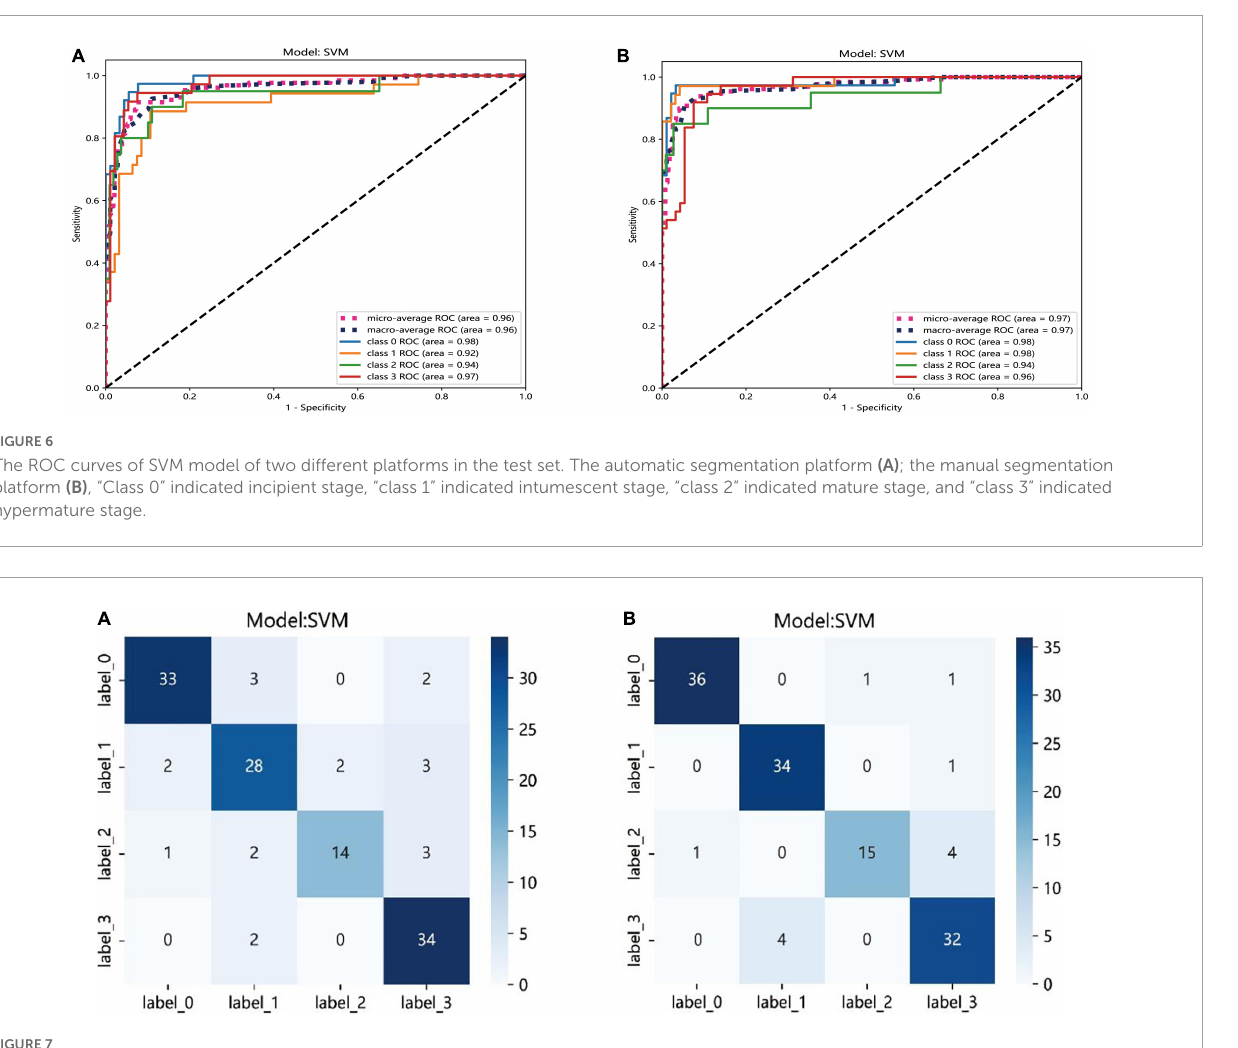
FIGURE7 The confusion matrix of the SVM model of two different platforms in the test set. Each column represents the predicted class and each row of the matrix represents the actual class. The automatic segmentation platform (A) ; the manual segmentation platform (B) . “Label 0” indicated incipient stage, “label 1” indicated intumescent stage, “label 2” indicated mature stage, and “label 3” indicated hypermature